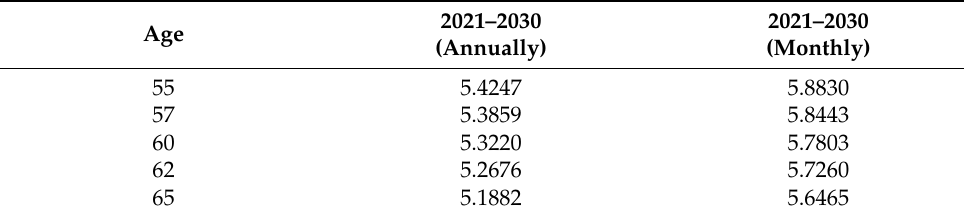
Table 7. Projected Annuity Factor Cost for Retirement Age—CBD Estimates.